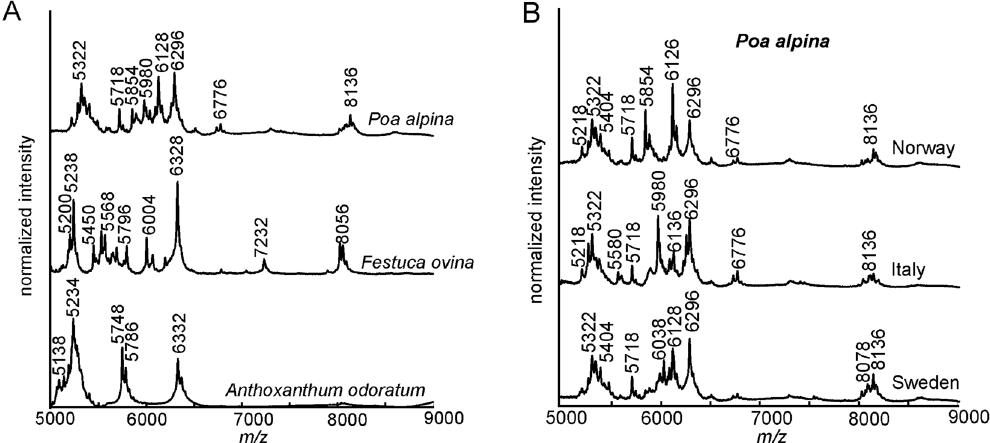
Figure 3. ( A ) MALDI TOF mass spectra of pollen from three different grass species in the range (m/z) 5000– 9000. ( B ) MALDI-TOF mass spectra for the three different population within Poa alpina in the range (m / z) 5000–9000. All spectra are averages of individual spectra from different samples, with n indicating the number of averaged